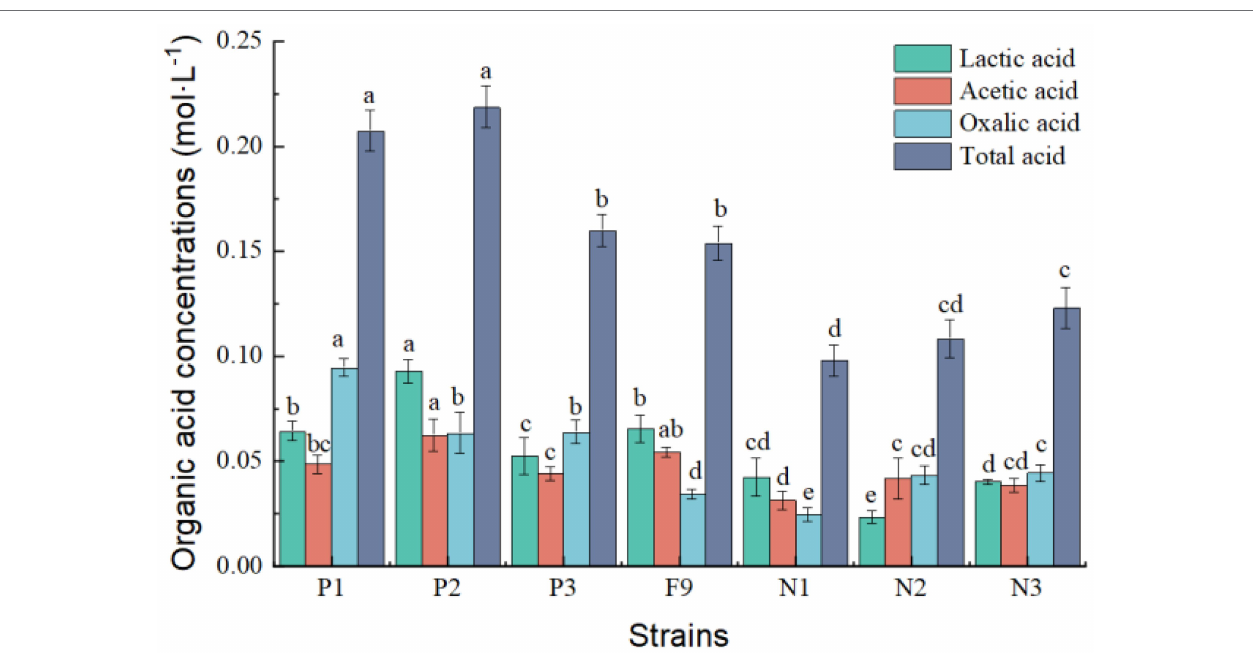
representing decreases of 20.36%, 11.89%, and 7.41%, respectively, compared with the original P. oxalicum F9 strain ( p < 0.05; Figure 5 ). The phosphate-solubilizing ability of positive mutant strains P1, P2, and P3 was enhanced by 56.88%, 42.26%, and 32.15%, whereas that of negative mutant strains N1, N2, and N3 was weakened by 47.53%, 35.27%, and 30.86%, respectively, compared with P. oxalicum F9 ( Table 2 ). The larger the total amount of organic acids secreted by the strains, the stronger their phosphate-solubilizing ability would be. The pH of the culture medium of the positive mutant strains P1, P2, and P3 was 2.10, 1.91, and 2.02, respectively, and there was no significant difference among the three ( p > 0.05). However, the pH of the culture medium of the three mutant strains was significantly lower than that of the P. oxalicum F9 ( p < 0.05). The capacity of the three mutant strains to acidify the growth medium was stronger than that of the P. oxalicum F9. The pH of the culture medium of inoculation strains N1, N2, and N3 was 3.42, 2.71, and 2.44, respectively. The pH of the culture medium of the three mutant strains was significantly higher than that of the original P. oxalicum F9 strain ( p < 0.05). The capacity of the three mutant strains to acidify the growth medium was weaker than that of the P. oxalicum F9. The three positive mutant strains had lower pH, and the three negative mutant strains had higher pH than P. oxalicum F9. Based on the phosphate-solubilizing ability of P. oxalicum F9 and the mutant strains ( Table 2 ), it can be inferred that the phosphate-solubilizing ability of phosphate-solubilizing P. oxalicum F9 had a negative correlation with the pH of the culture medium.